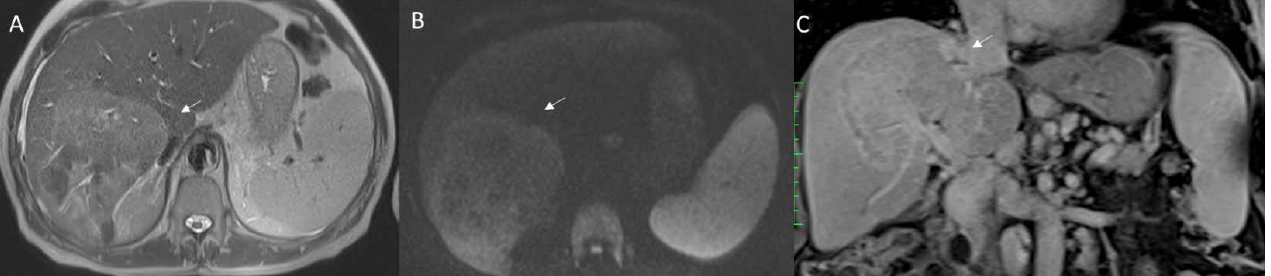
Figure 6. Cholangiocarcinoma patient, classified as LR-M according to LI-RADS, due to targetoid appearance (arrow) in T2-W ( A ) sequence, in ( B ) DWI, and ( C ) late phase of contrast